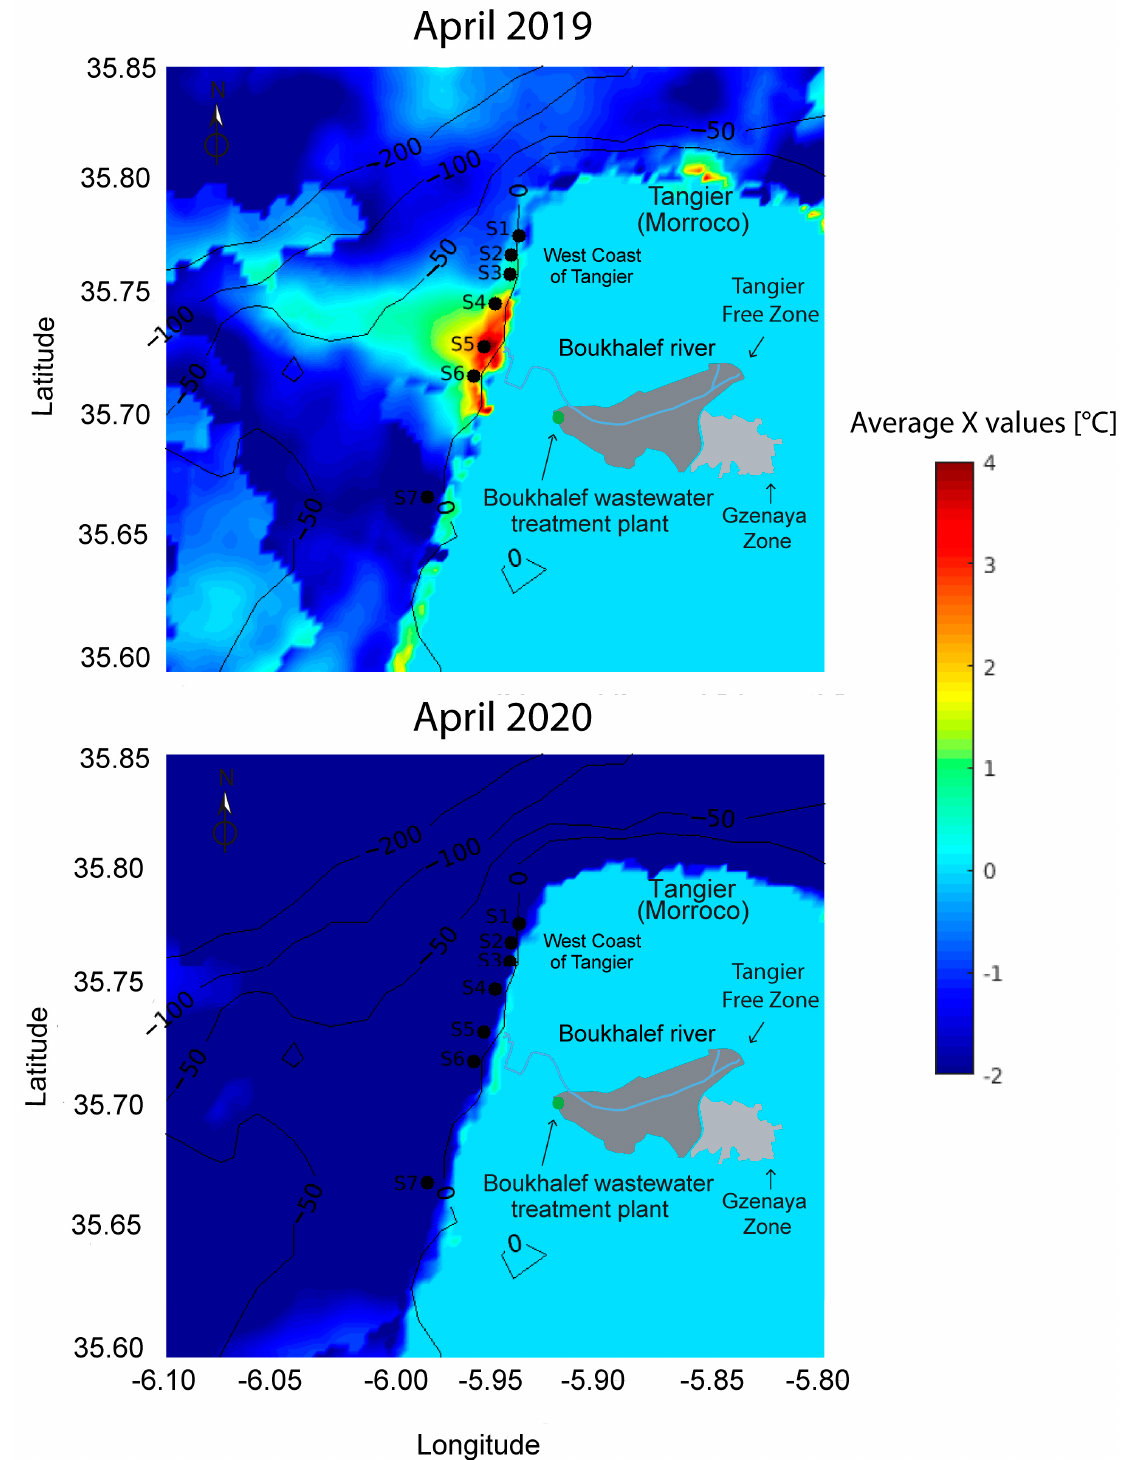
Figure 8. Average X (WST − Ta (air temperature)) in April 2019 and 2020 along the west coast of Tangier, Morocco.